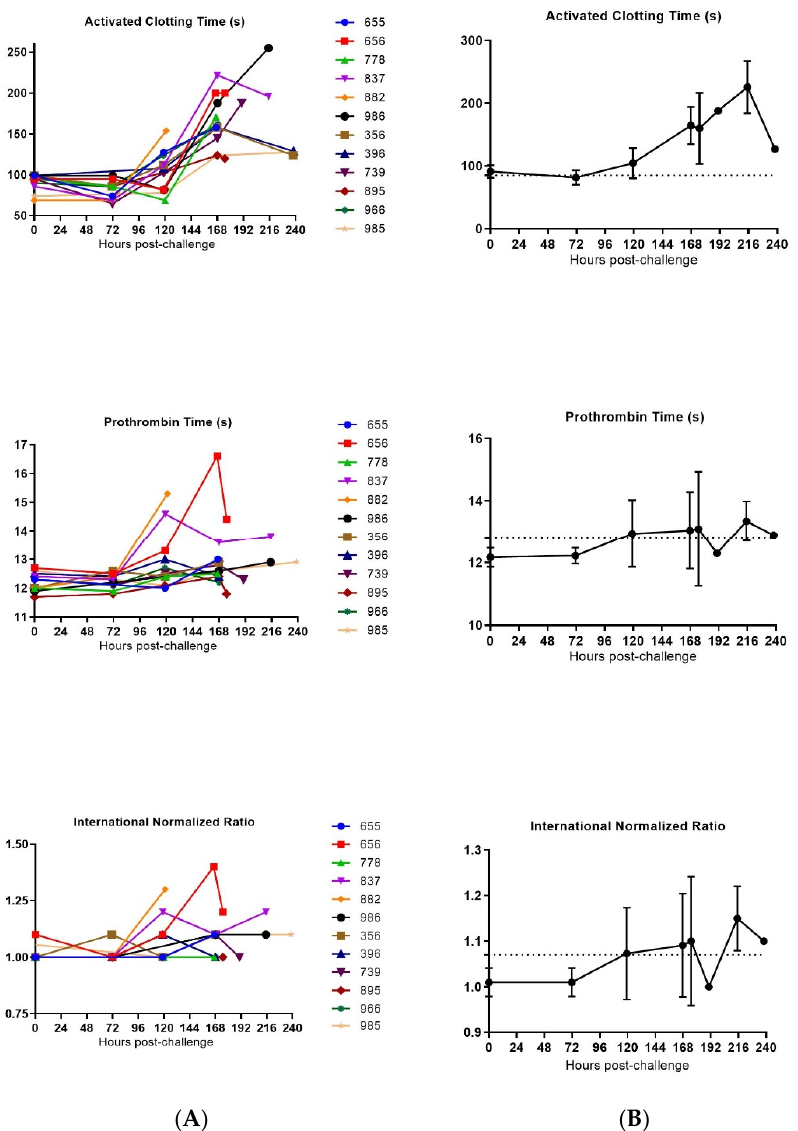
Figure 9. Coagulation parameters in SUDV-challenged animals. ( A ) Individual coagulation pa- rameters evolution versus time. ( B ) Group means coagulation parameters versus time. Average measurements taken before exposure serve as baseline (represented by horizontal straight dashes lines). Error bars represent the standard error of the